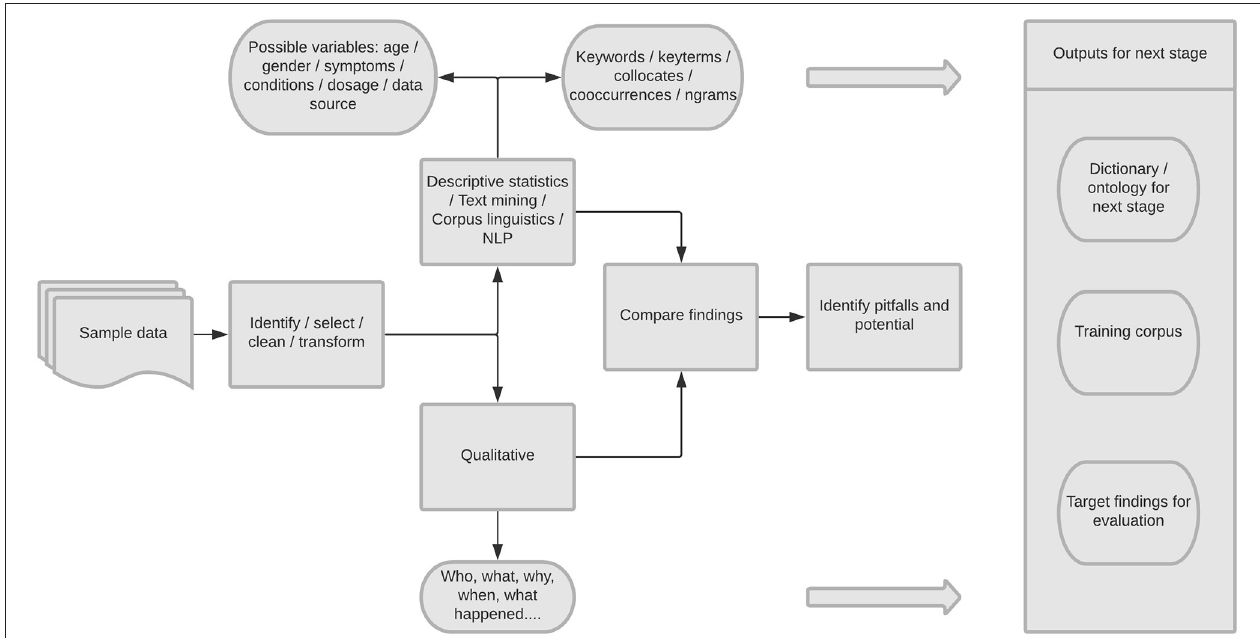
FIGURE 1 | Overview of study